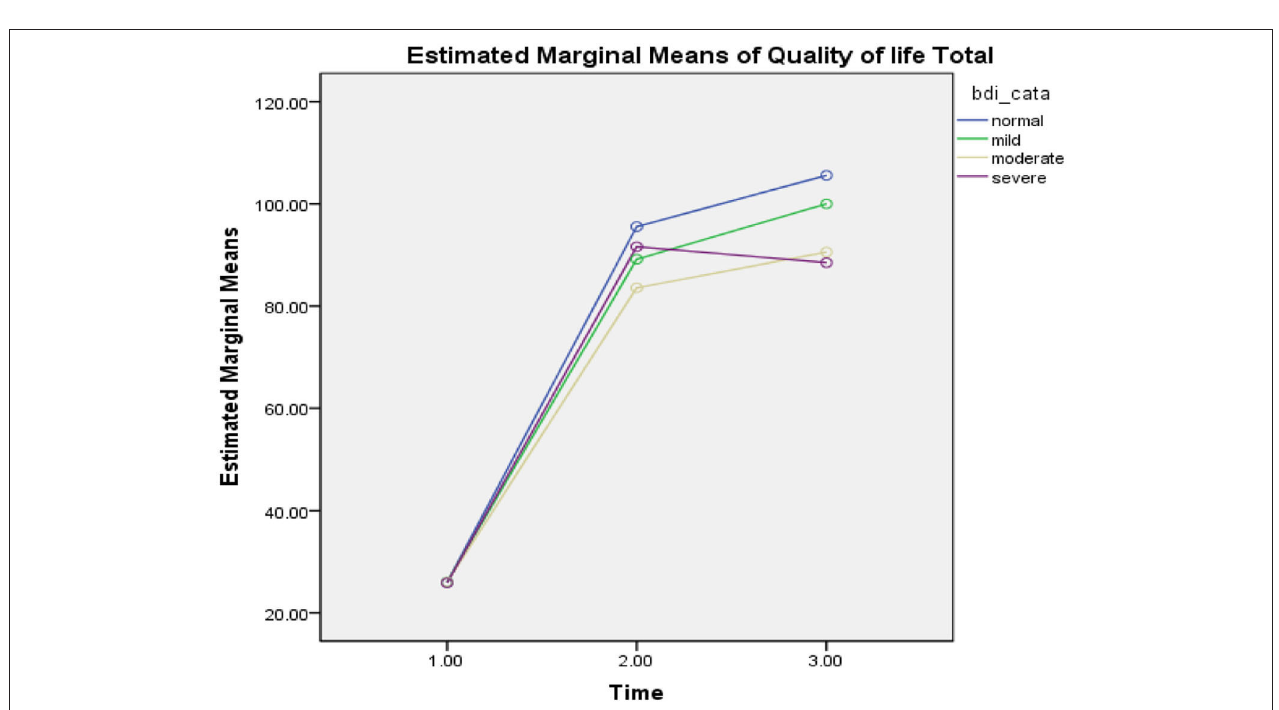
FIGURE 4 | Mean difference of quality of life between T-0 (pretesting phase), T-1 (posttesting phase), and T-2 (follow-up phase) with different levels of depression in Pakistan students during the COVID-19 epidemic lockdown ( N = 40). Time, three phases; bdi_cata, severity level of depression; quality of life total, quality of life.